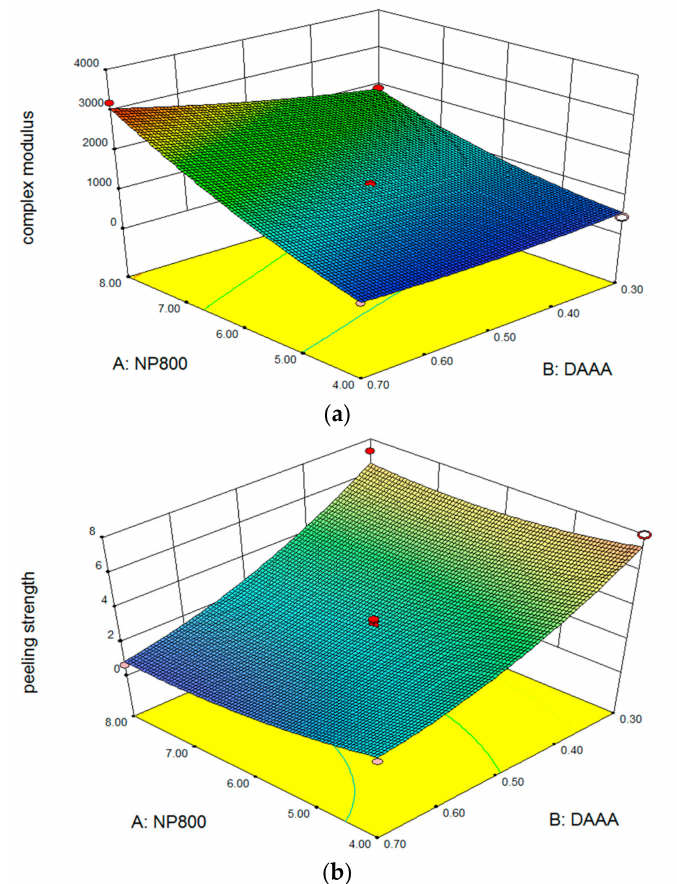
Figure 1. Response surface of contour plots to show effects of tested factors on complex modulus ( a ) and peeling strength ( b ).